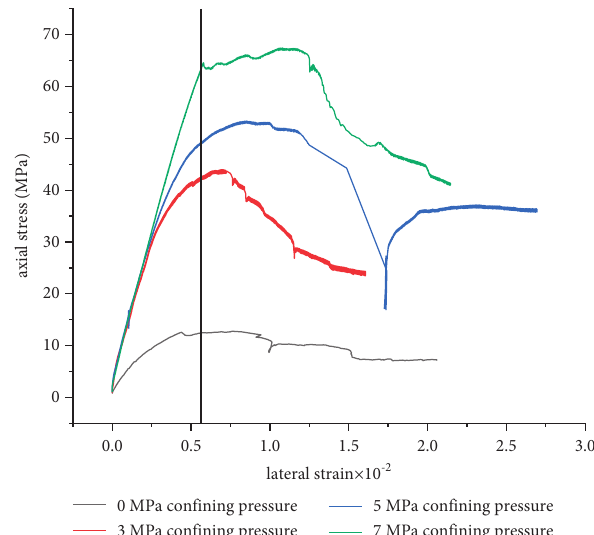
Figure 8: Characteristic curves of axial stress versus lateral strain.